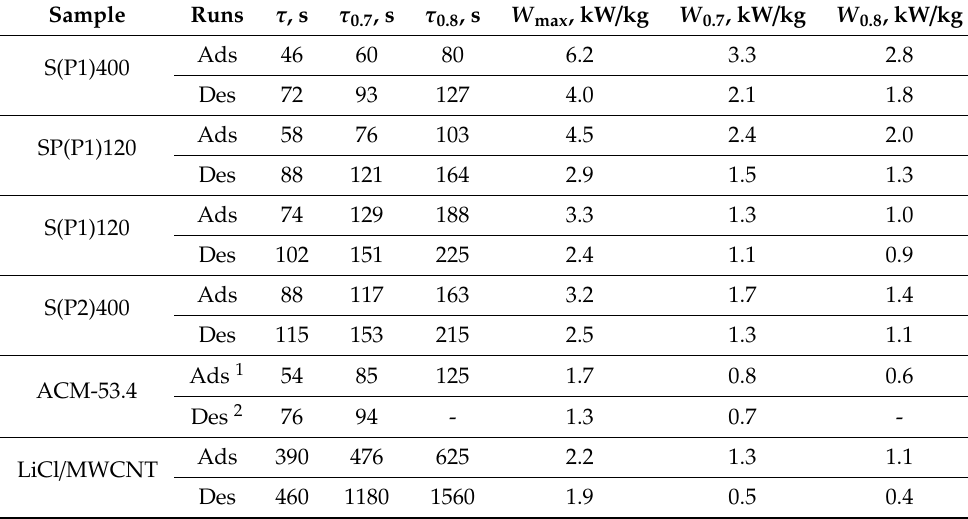
Table 5. Characteristic times τ , τ 0.7 , τ 0.8 and specific powers W max , W 0.7 , и W 0.8 for the